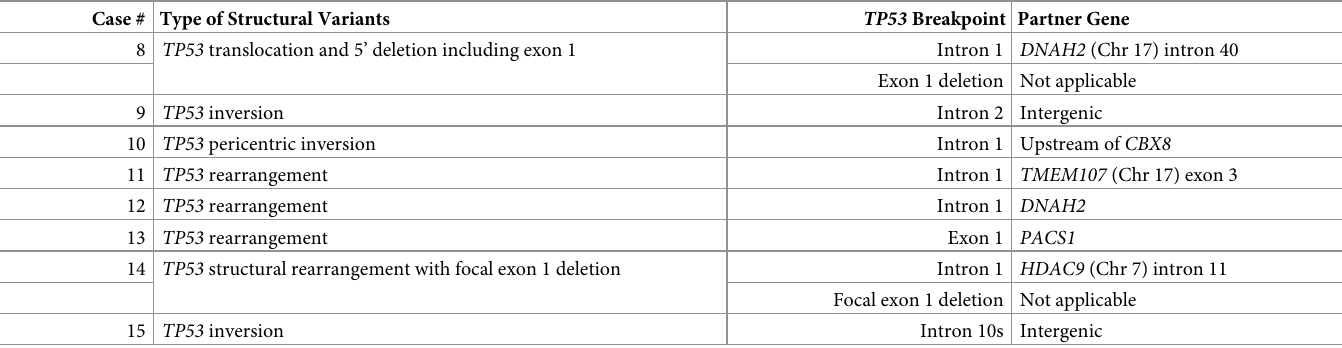
Table 4. Structural variants in prostate